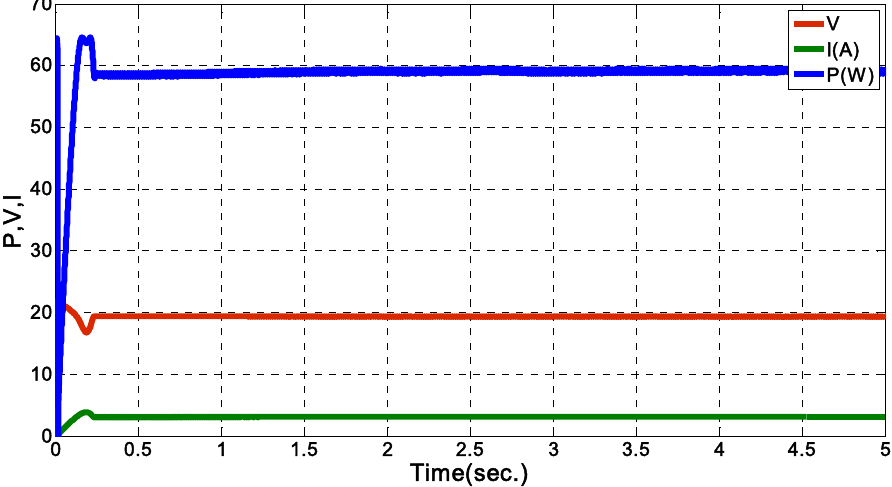
Figure 12. Time response of a conventional ESC system under uniform irradiance of 1 kW/m 2 at 25 °C.